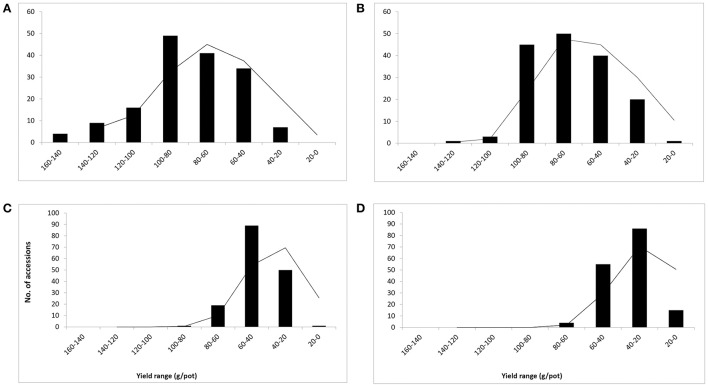
Frequency distribution and yield range (g/pot) of 160 buffelgrass accessions (Mean of dry weight at A–D at heading stage). Whereas, A = 0, B = 10, C = 15, and D = 20 dS m−1 salinity level.